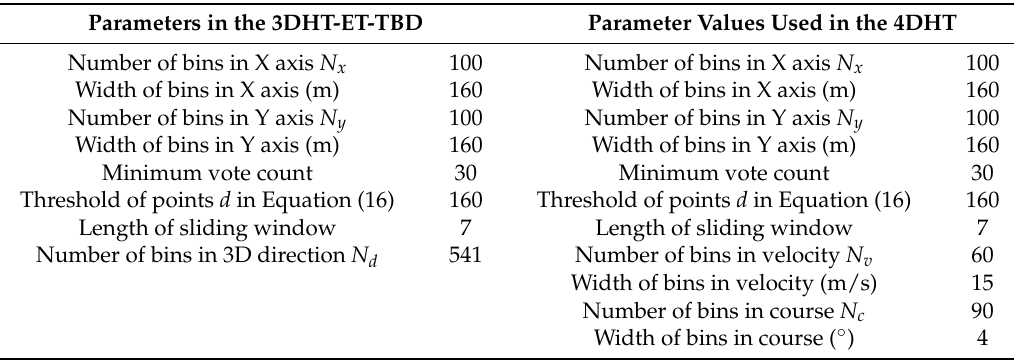
Table 4. Parameter values used for simulations and real